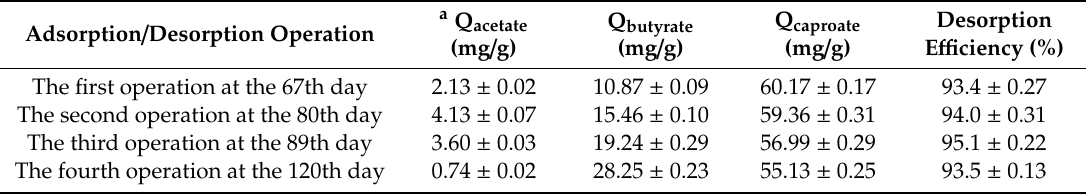
Table 3. Adsorption–desorption performance of carboxylates during anion-exchange resin production of caproate using the actual fermentation